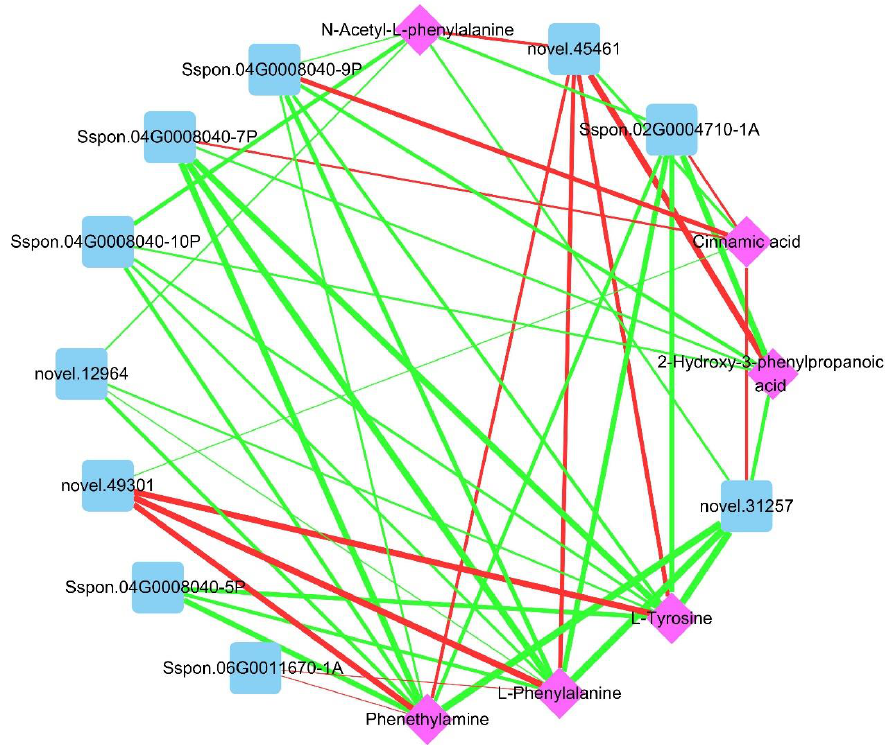
Figure 8. Gene – metabolite network graph of phenylalanine metabolism when comparing the DS and COS groups. Blue Figure 8. Gene–metabolite network graph of phenylalanine metabolism when comparing the DS squares and pink diamonds represent genes and metabolites, respectively. Green lines indicate negative correlations and and COS groups. Blue squares and pink diamonds represent genes and metabolites, respectively. red lines are positive correlations. The line thickness represents the magnitude of the correlation coefficient, which ranged Green lines indicate negative correlations and red lines are positive correlations. The line thickness from 0.919 to 0.998. represents the magnitude of the correlation coefficient, which ranged from 0.919 to